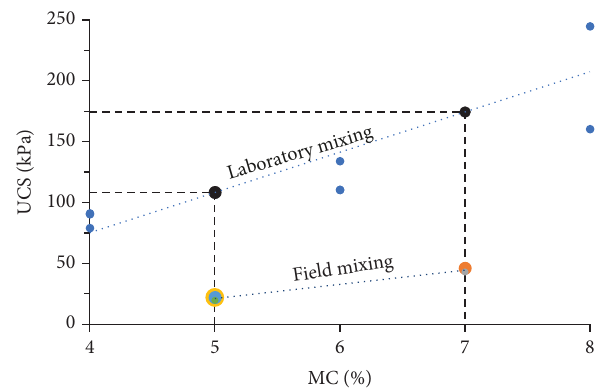
Figure 10: Comparison of laboratory and feld UCS for soil-binder mixture (MC%: Multicem